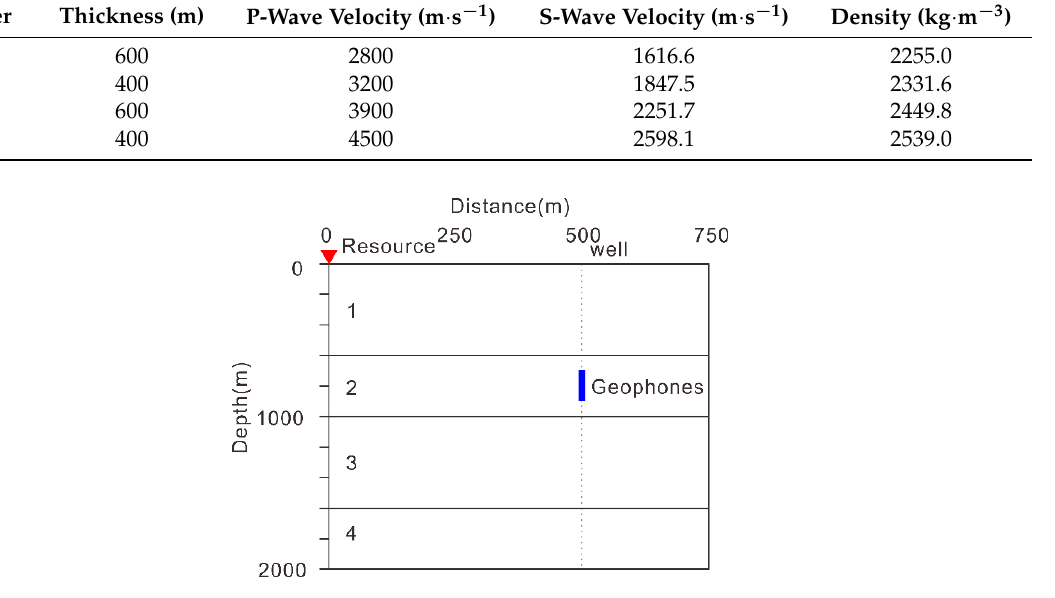
Figure 4. Sketch map of model 1. The red triangle is the resource and the blue line is the sequence of the geophones.